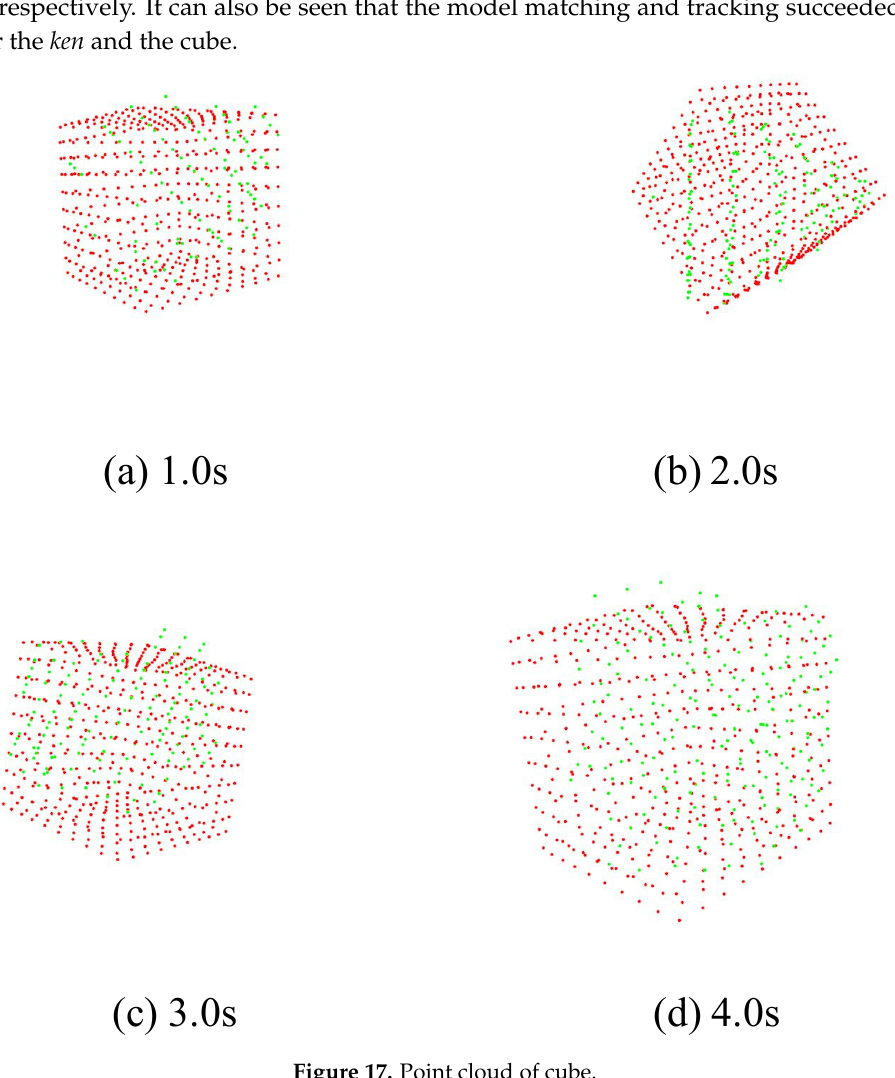
Figure 17. Point cloud of cube.